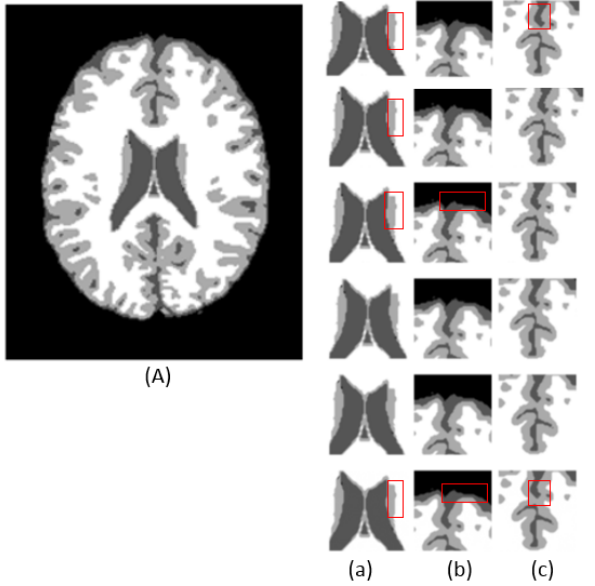
Fig. 10 Two-time reconstructed MR brain image using the six SR methods NARM, CSFI, NeedFS, IUIE, FCME, and our method, in order.